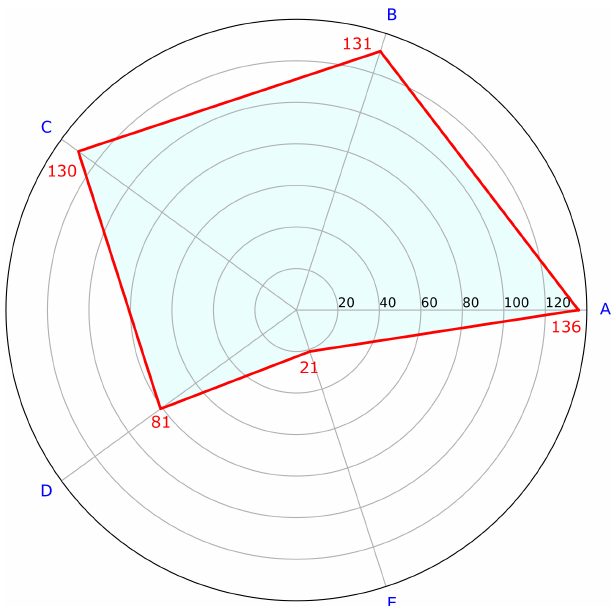
Figure 17. Predicted number of people in